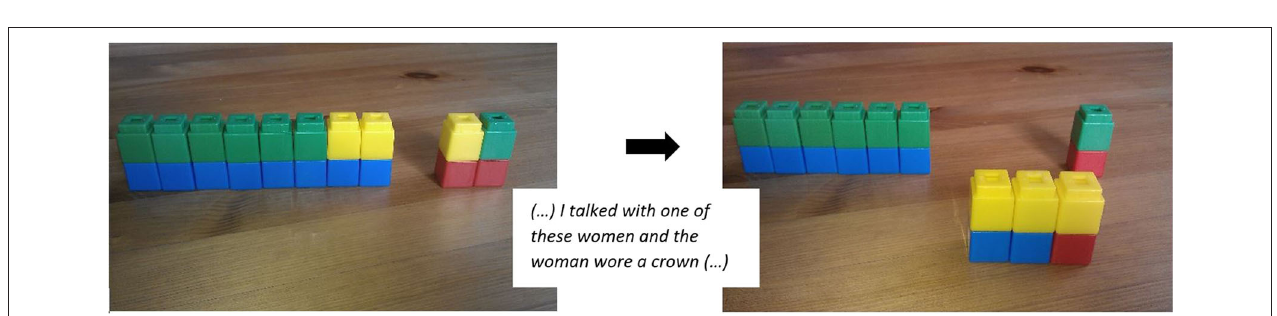
FIGURE 2 | Iconic representation of a typical Bayesian task: Icon array. See Till (2015, p. 91).